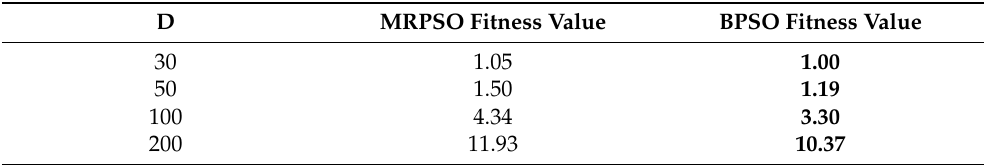
Table 15. Mean of the particle best-fit values in MRPSO and BPSO on f 2 . The bold numbers refers to the better results.